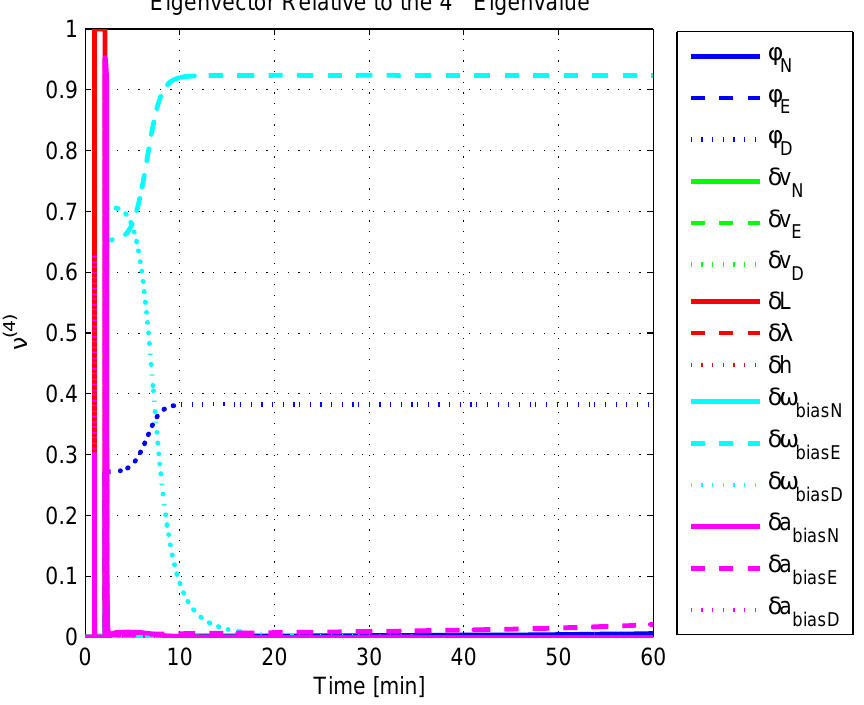
Figure 19. Eigenvector relative to the fourth eigenvalue in the experimental